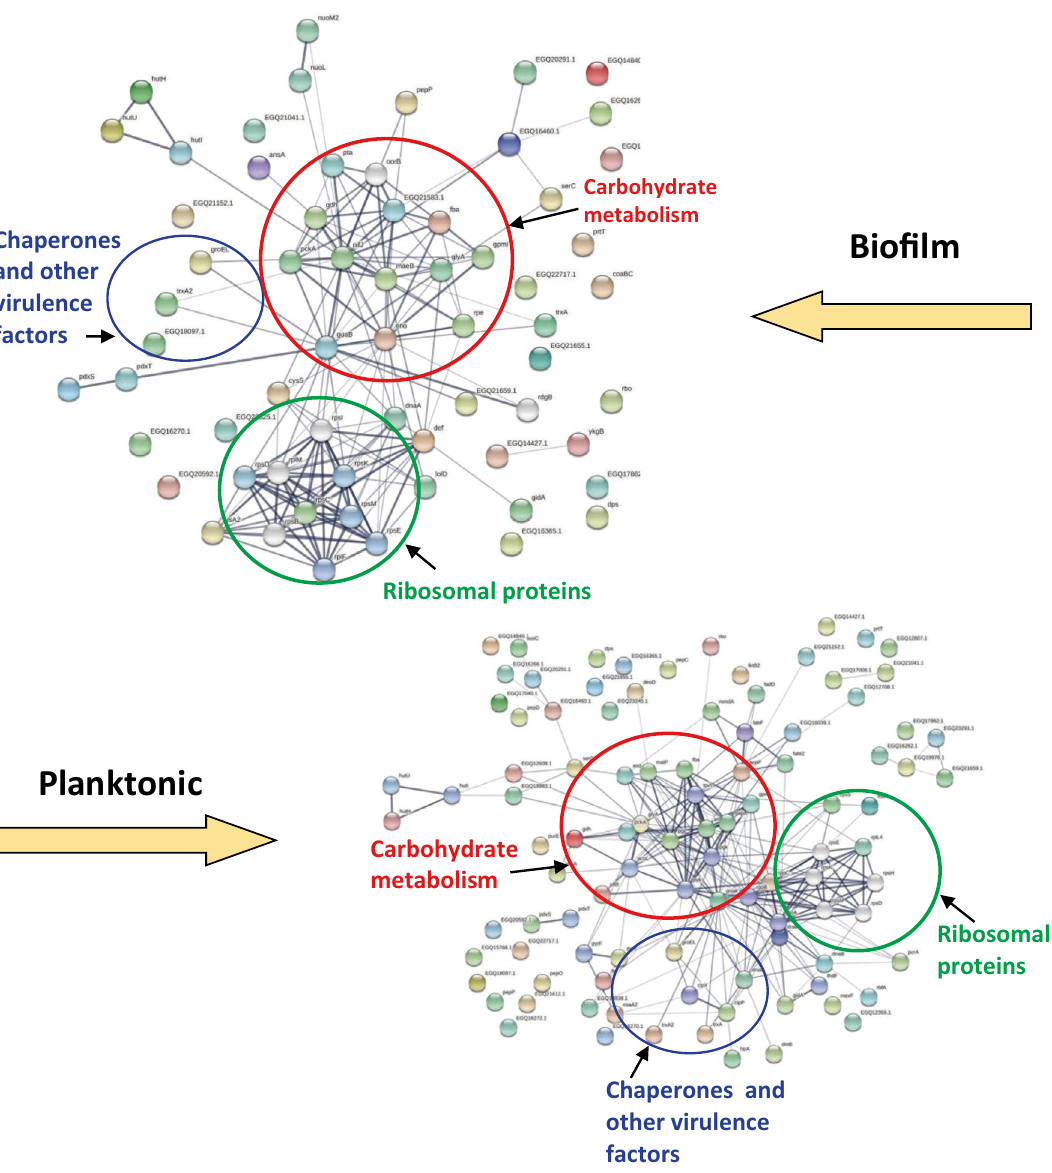
Figure 4. Functional protein association networks of P. intermedia proteome from biofilm and planktonic cells. The online tool STRING was used for grouping the secreted proteins based on functional networks. Minimum interaction scores were set at a strong confidence level of 0.7. The three major network groups formed are shown in dotted circles. The thickness of the lines in the network indicates the strength of data